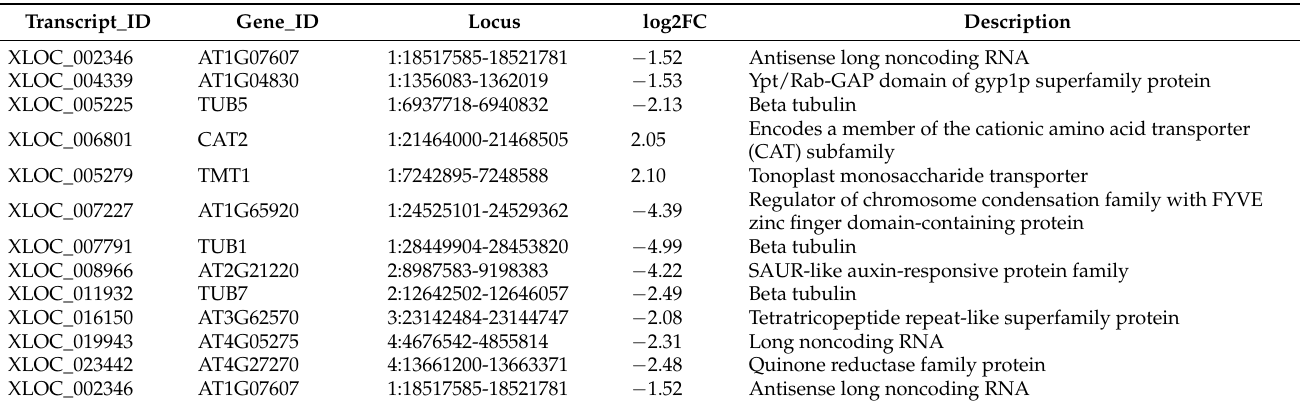
Figure 6. Subcellular localization prediction of DEG expression products. M, mitochondrion (158); S, secretory pathway (472); C, chloroplast (266); T, tonoplast (12); other (799); unknown (2226). Tonoplast-residing proteins were predicted by a BLASTx-based search of proteins identified in previous studies by Endler et al. [40] and Szponarski et al. [41], and other locations were predicted using TargetP.